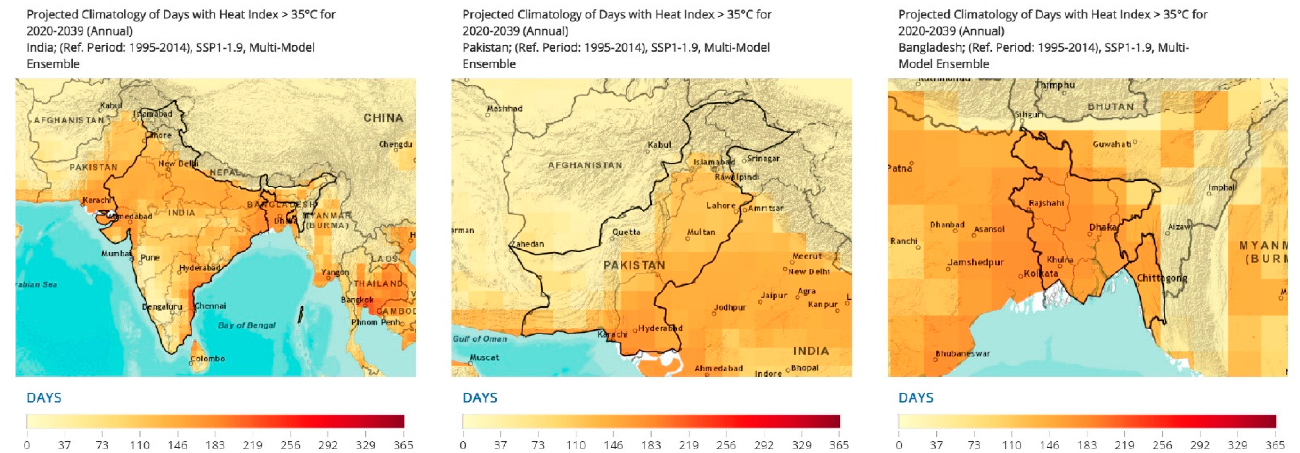
Figure 9. Projected Climatology of Days with Heat Index >35 ◦ C for 2020–2039 (Annual) [49]. Annual projections for the years 2020–2039 are made for the heat index (>35 ◦ C). A reference period of 1995–2014 was utilized. The SSP1–1.9, multi-model ensemble was utilized. The projections are scaled for 365 days as depicted in the